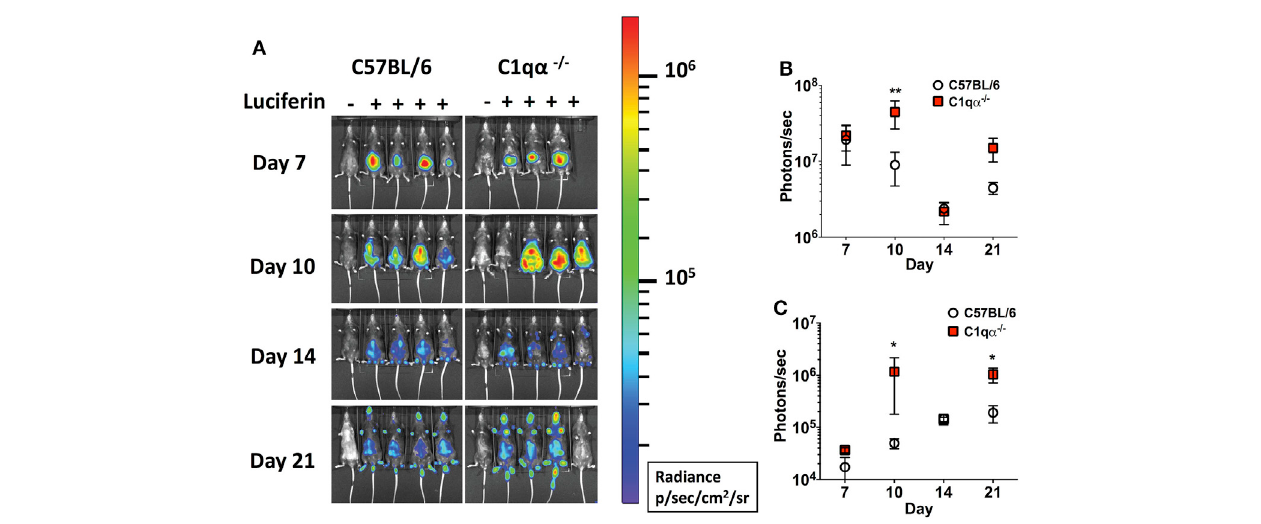
FigUre 2 | Temporal and spatial tracking of Borrelia burgdorferi strains following infection in C1q α − / − mice. (a) C57BL/6 and C1q α − / − mice were infected with B. burgdorferi containing firefly luciferase at a dose of 10 4 . Mice were treated with d -luciferin at 7, 10, 14, and 21 days post-infection and imaged. For each image shown, the mouse on the far left was infected with B. burgdorferi but did not receive d -luciferin serves as a background control. The image shown was obtained from a 10 min exposure. All images from each time point were normalized to the same photon/second (p/s) range of 1.15 × 10 4 to 1.86 × 10 6 and displayed on the same color spectrum scale (right). (B) Quantification of in vivo luminescence from each mouse. Total detected light was measured for each individual mouse in its entirety, and the total flux value was determined (in photons/second). The total flux values from mice treated with d -luciferin were normalized by subtracting the background total flux value of the infected mouse with no added luciferin relative to mice that were given luciferin. Total flux was determined after infection at days 7, 10, 14, and 21 for mice infected with 10 4 B. burgdorferi . (c) Quantification of in vivo luminescence from the joint region. The joint localized signal was selectively measured, and the total flux value was determined (in photons/second). Each data point represents the average signal from the left and right ankles of each mouse. White circles and red squares represent signal from C57BL/6 and C1q α − / − mice, respectively, both infected with ML23/pBBE22 luc ( n = 3 or 4; * P < 0.05 and ** P <